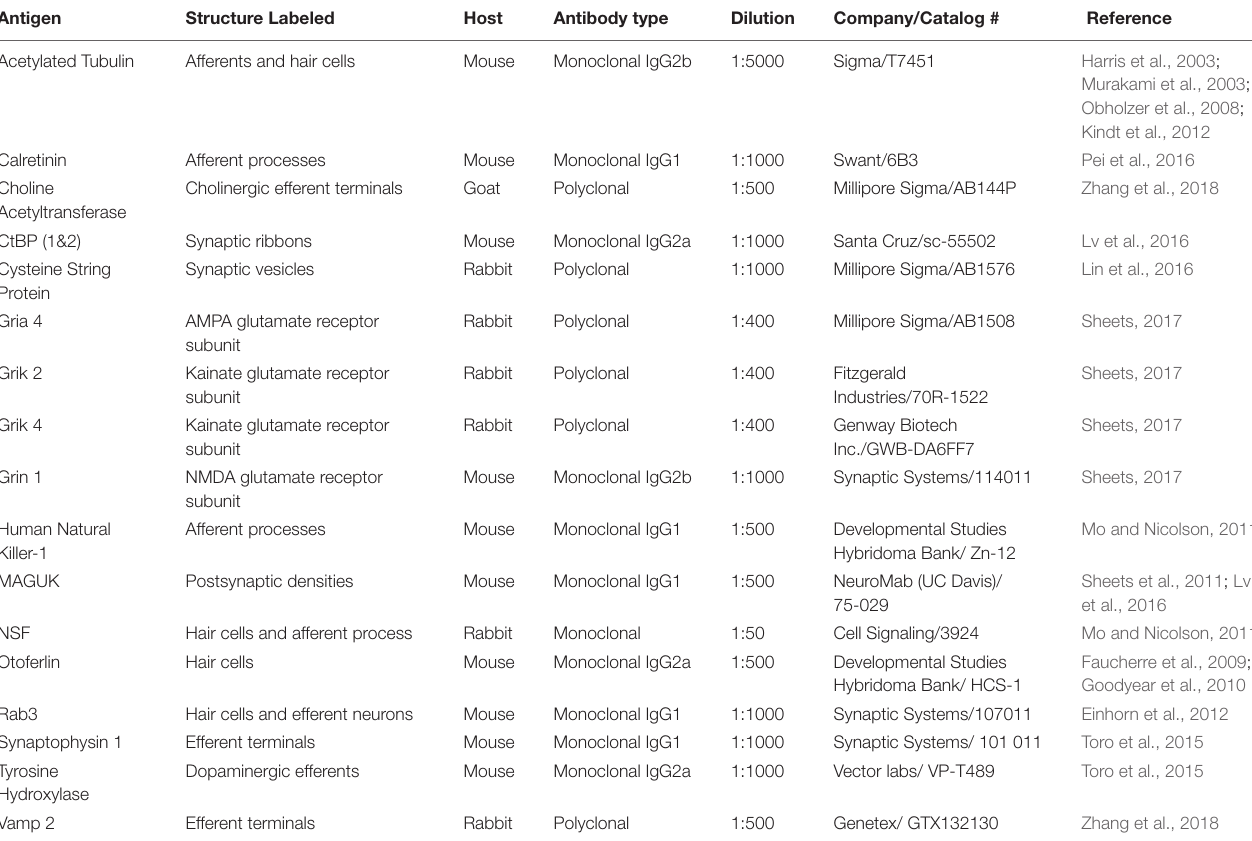
TABLE 1 | Commercially available antibodies labeling zebrafish hair-cell synaptic proteins. Antigen Structure